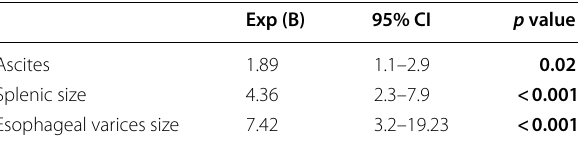
Table 6 Baseline data of the study patients according to endoscopic grades ( N 100) =